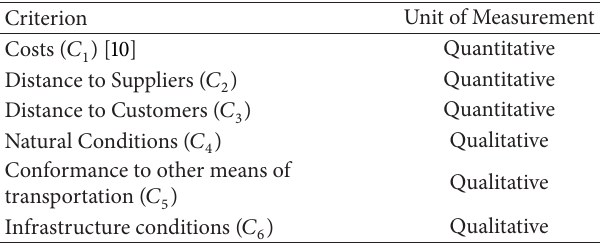
Table 1: Criteria for location selection.